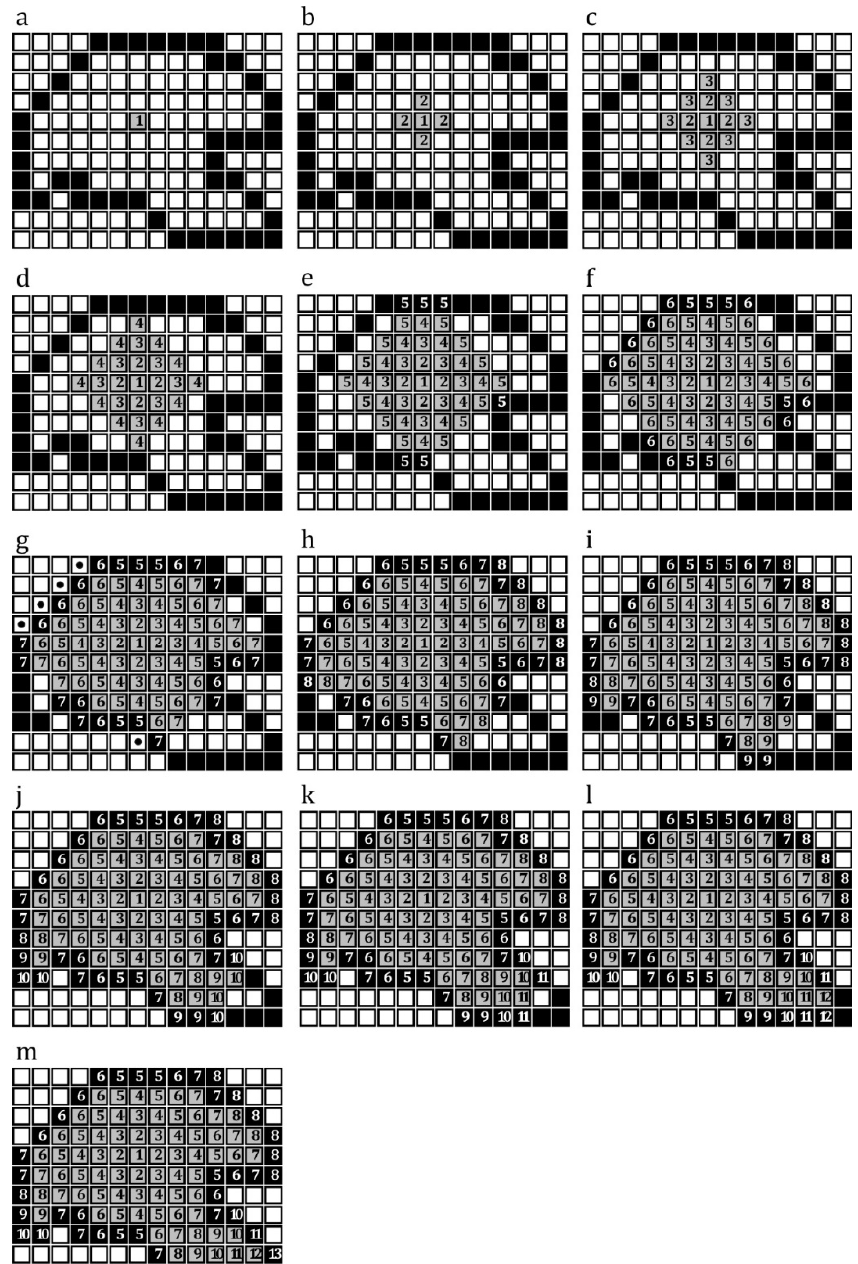
Figure 1. Detection of the border of an arbitrary domain using the Burning Algorithm. ( a ) A white pixel inside the domain is selected. ( b ) The BA searches for white and black pixels around the selected pixel in four orthogonal directions. ( c ) The BA searches for white and black pixels around the detected white pixels in the previous iteration. ( d – m ) This process continues until there is no white pixel inside the domain ( m ).